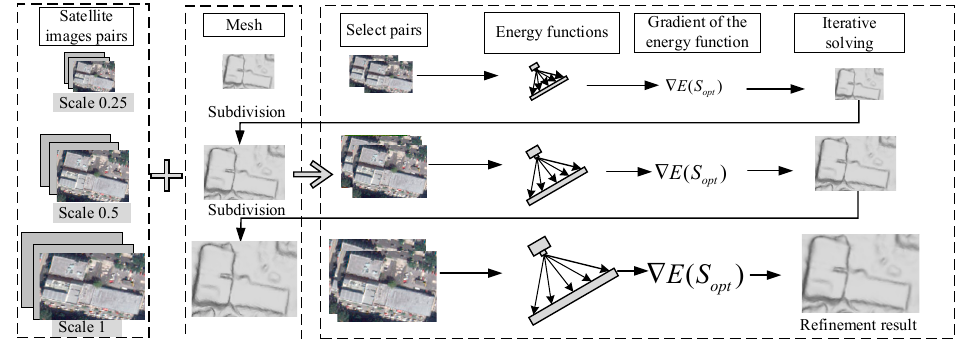
Figure 6. Multi-scale refinement strategies from low to high.